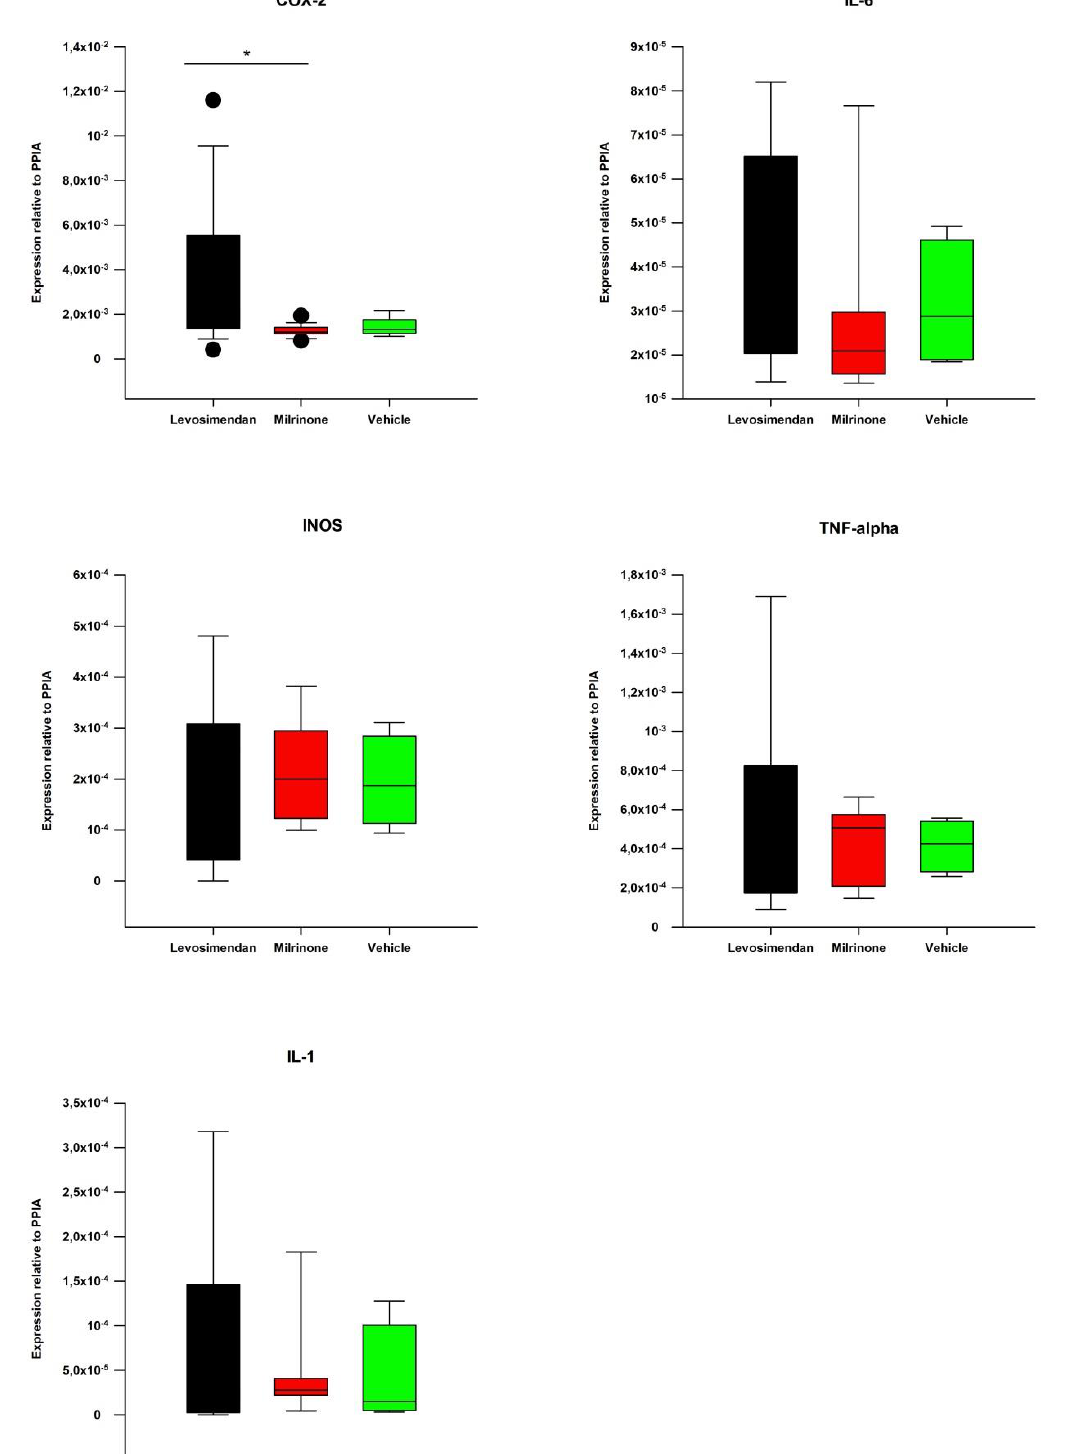
Figure 5. Tissue sample analyses. Inflammatory marker expressions of COX-2, IL-6, IL-1b, INOS, TNF-alpha. * indicates p < 0.05 levosimendan vs. milrinone for COX-2. • statistical outliers. COX-2: Cyclooxygenase-2. IL-6: Interleukin-6. IL-1b: Interleukin-1b. INOS: Inducible nitric oxide synthase. The regional distribution of ventilation did not differ between the groups. Lung injury scoring showed no relevant intergroup differences. The alveolar fluid clearance showed